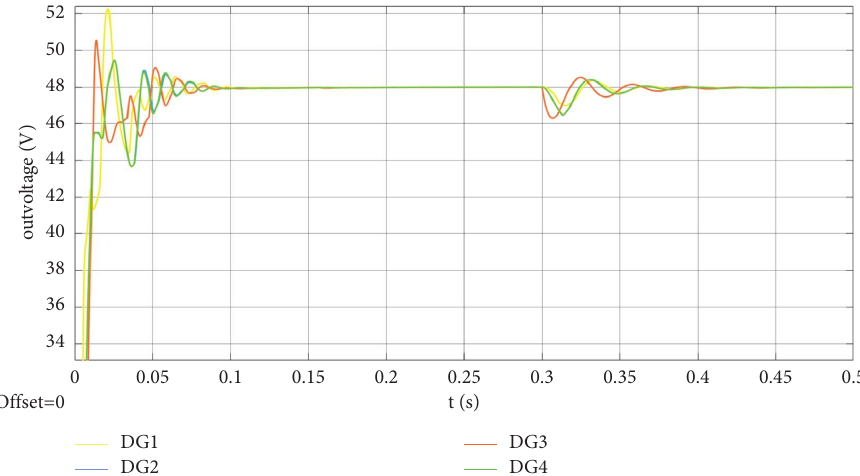
Figure 11: Output voltage of each unit after converter # 3 is disconnected.